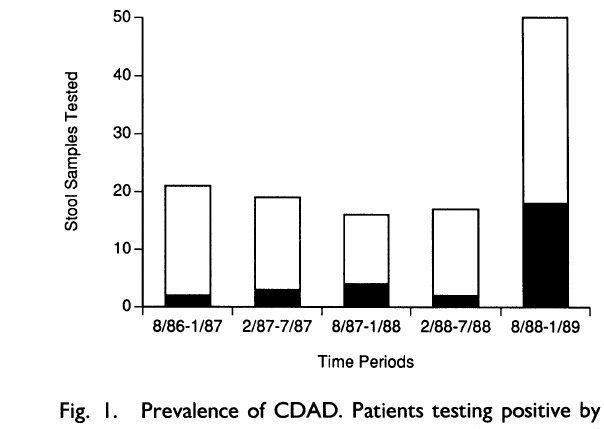
Fig. I. Prevalence of CDAD. Patients testing positive by the CDT assay are represented by the shaded areas and increased from 16% of total samples tested during the first 24 months of the study to 40% during the last 6 months (P 0.0037).